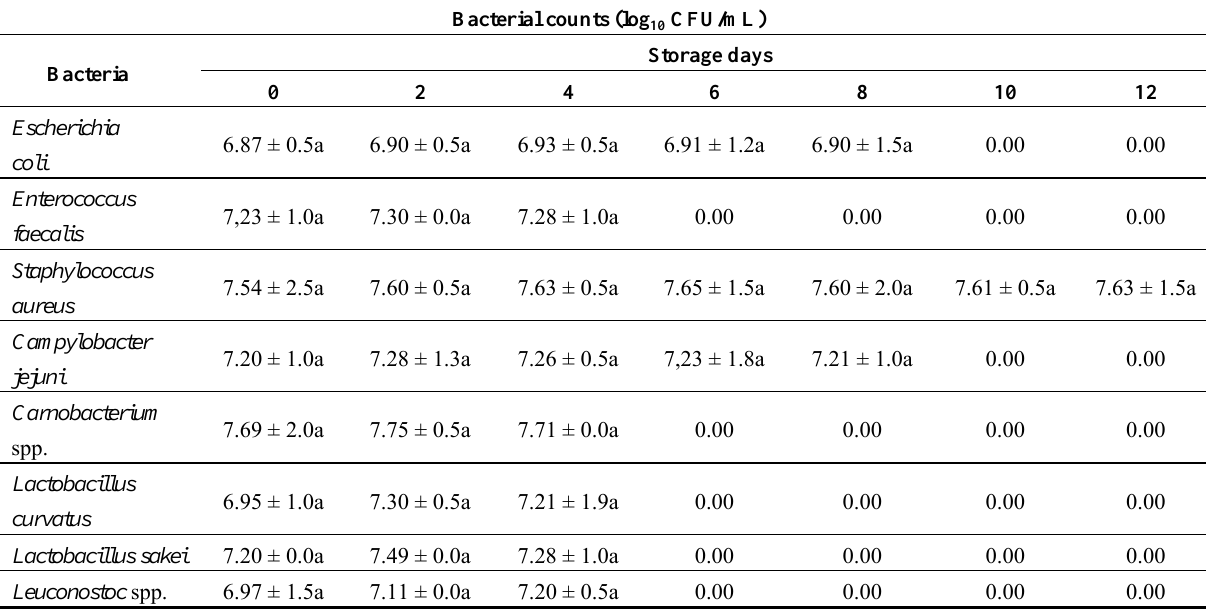
Table 4. Bacteria counts obtained using the official microbiological analysis at 2 days intervals up to the 12th day of refrigerated storage to test the antibacterial activity in experimentally contaminated vacuum-packed